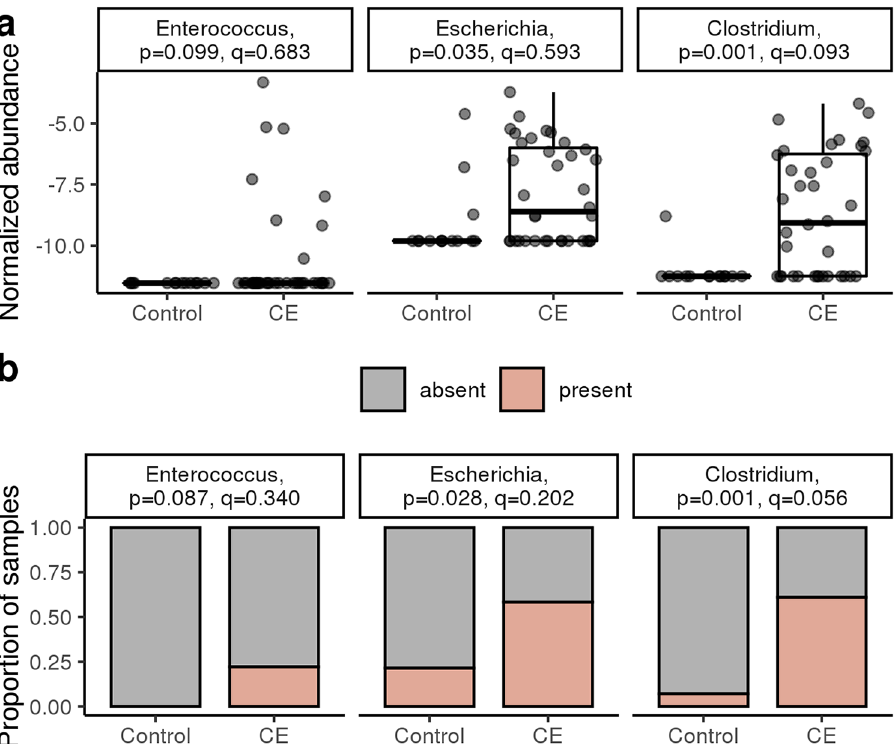
Figure 2. Comparison of selected bacterial genera associated with chronic enteropathy (CE) in dogs and cats and humans with inflammatory bowel disease in the existing literature ( Enterococcus, Escherichia and Clostridium) in cats with CE as compared to control cats. Although, all 3 selected genera are over-represented in cats with CE as compared to control cats, only Clostridium was statistically significant (q < 0.1). ( a ) Normalized abundance of Enterococcus , Escherichia , and Clostridium in control and CE cats at time of diagnosis. Statistical testing performed on linear fixed model, with significance at q < 0.1. ( b ) Contingency analysis showing prevalence of a given genus in control and CE